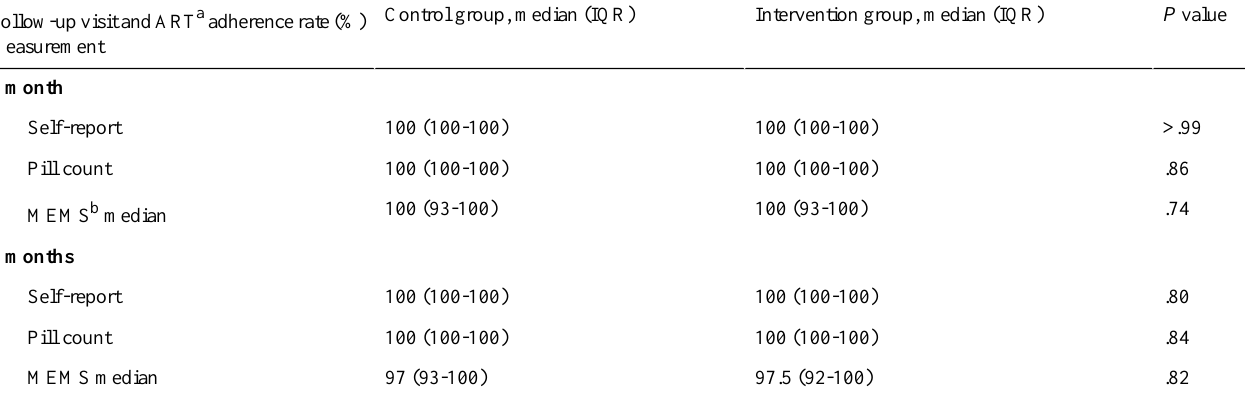
Table 1. Comparison of median antiretroviral therapy adherence rates between the control group and intervention group at the 1-month and 2-month follow-up visits (N=40).